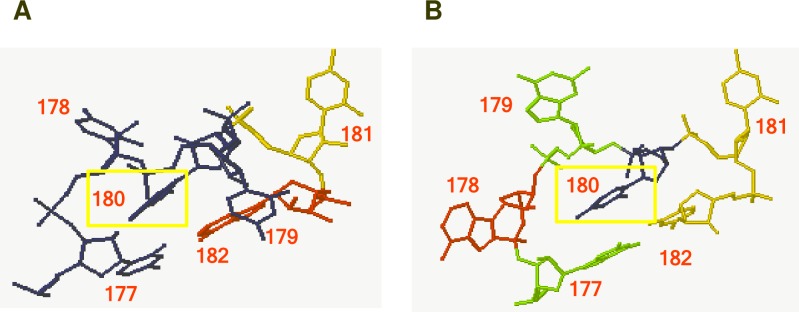
Comparison of loop 27 structural models for wild type PSTVd and the U178G/U179G mutant.(A) Structural model of wild type loop 27 (5'-UUUUCA-3', positions 177–182, loop bases underlined), shown from a different perspective than in Fig 2A. U179 and C181 bulge out of the structure, while U180 (yellow box) stacks on the closing WC base pair between U177 and A182. (B) The predicted structure of the U178G/U179G mutant (5'-UGGUCA-3') is compatible with structural model (HL_4OOG_001; 5'-GAGUCC-3'). The HL_4OOG_001 model structure shown has bulges at positions corresponding to 178, 179, and 181. U180 (yellow box) stacks on the closing WC base pair between G177 and C182.